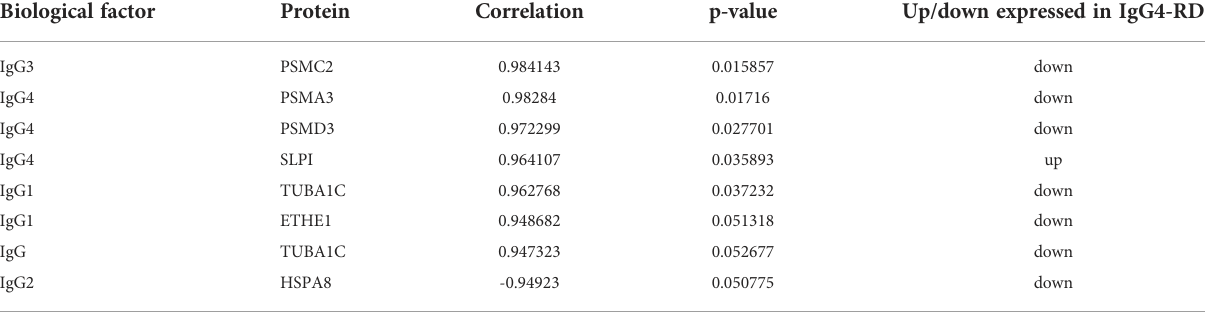
TABLE 5 Differentially expressed proteins correlated with important clinical parameters of IgG4-RD patients with salivary gland involvement in saliva. Biological factor Protein Correlation p-value Up/down expressed in IgG4-RD